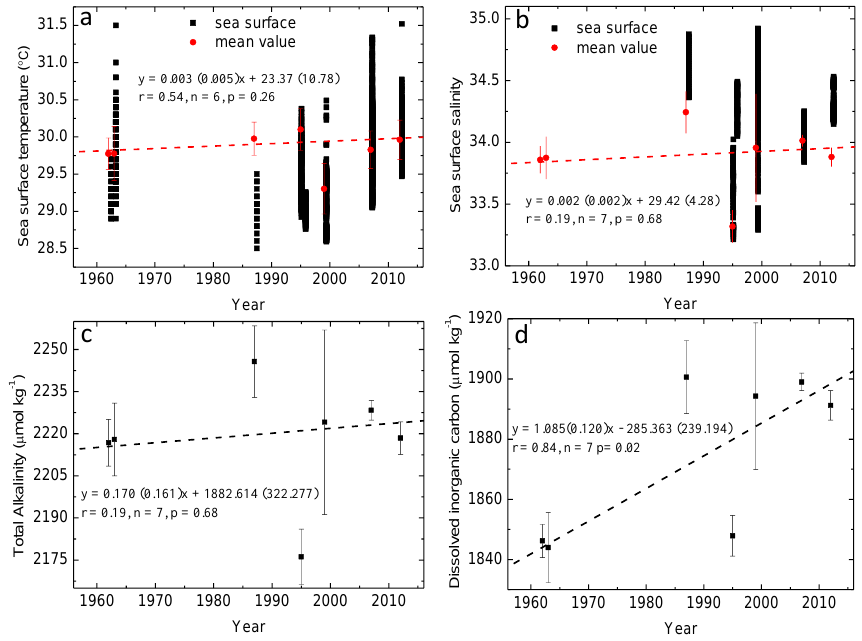
Fig. 7. Figure 7. Temporal changes in sea surface temperature (a) , salinity (b) , TA (c) , and DIC (d) . TA was estimated from SSS, and DIC was calculated from p CO 2 and TA as described in Sect. 2.4. All data are corrected to the same month